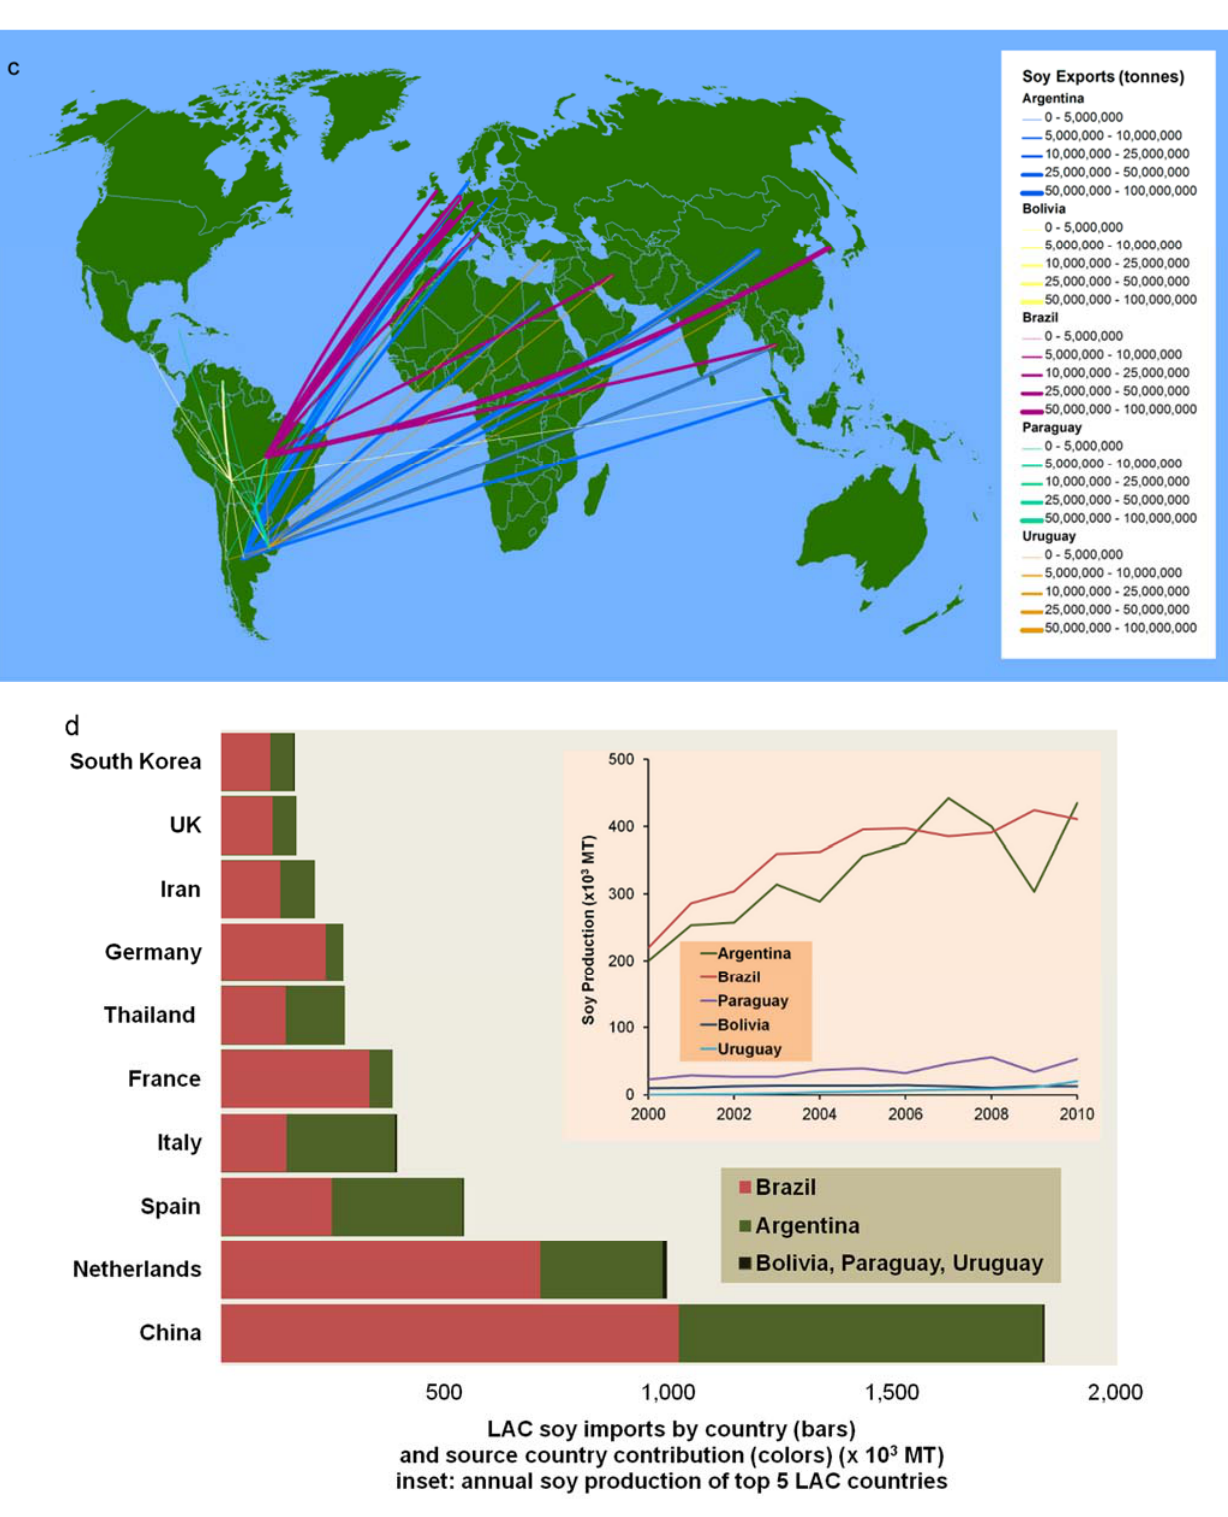
Figure 3. ( a – d ) Trade flows and production for beef and soy from LAC to top importers 2000– 2010.